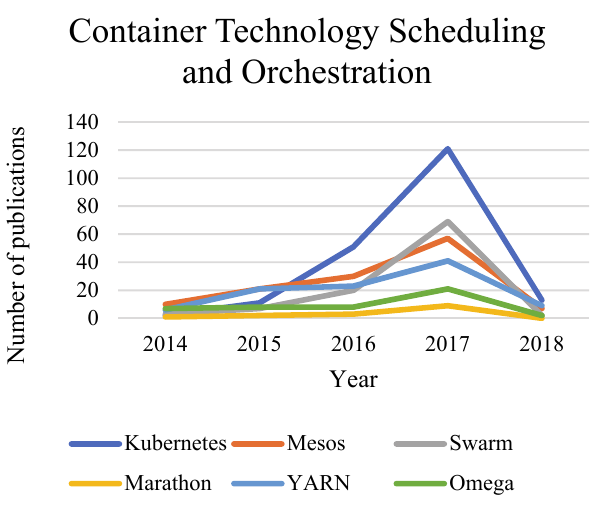
Fig. 6. Container technology core – Layers 5 and